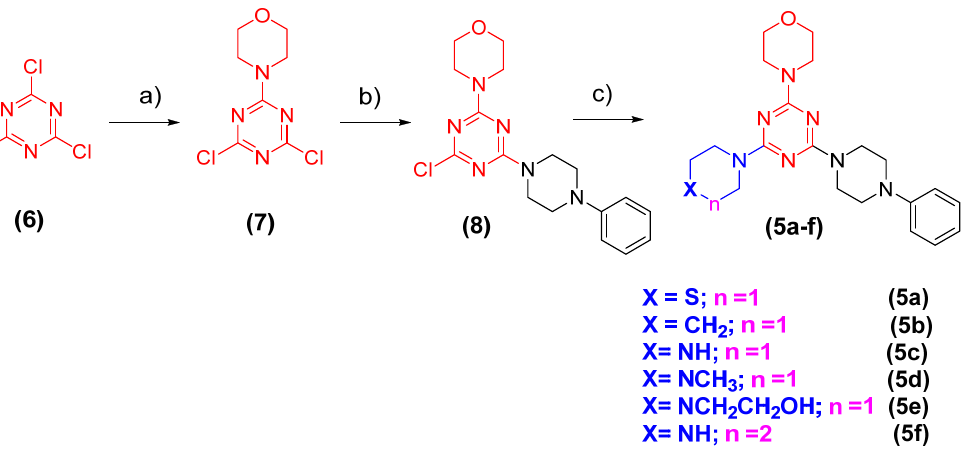
Figure 3. General methodology for synthesis of compounds 5a-f . Reagents and conditions: ( a ) morpholine, Et 3 N, THF, − 20 °C to 0 °C; 6 h; 91%; ( b ) phenylpiperazine, Et 3 N, THF, − 20 °C to 0 °C; 24 h; 90%; ( c ) amines, Et 3 N, THF, re fl ux; 18–24 h; 50–58%.